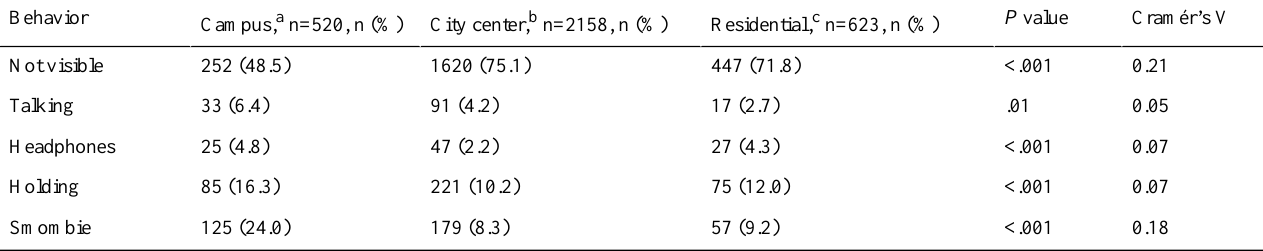
Table 4. Influence of the city area on pedestrian smartphone usage